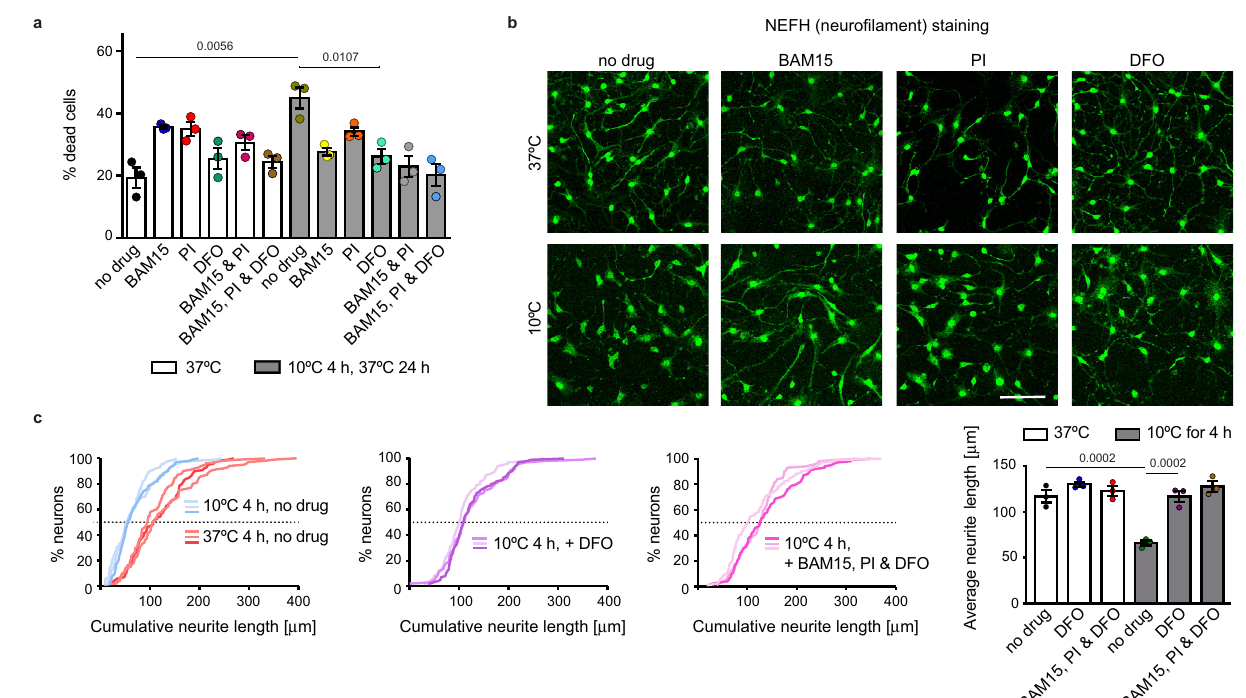
Fig. 8 | Reducing free iron protects murine neurons from cold-induced degeneration.a Deferoxamine, similarto BAM15andproteaseinhibitors, increases the viability of cold-exposed murine neurons. Cells were incubated continuously at 37°C or subjected to 10°C (4h) with 24h rewarming (37°C) in the absence or presence of DFO (100 µ M), BAM15 (100nM), PI (1:500 dilution) or their combina- tions. Cell viability was examined by staining with propidium iodide. Error bars represent SEM, n =3 independent experiments. 600 – 800 cells were examined per condition. p values calculated using multiple two-sided t -test (left) or two-way ANOVA plus Tukey post hoc test (right). b Deferoxamine, similar to BAM15 and